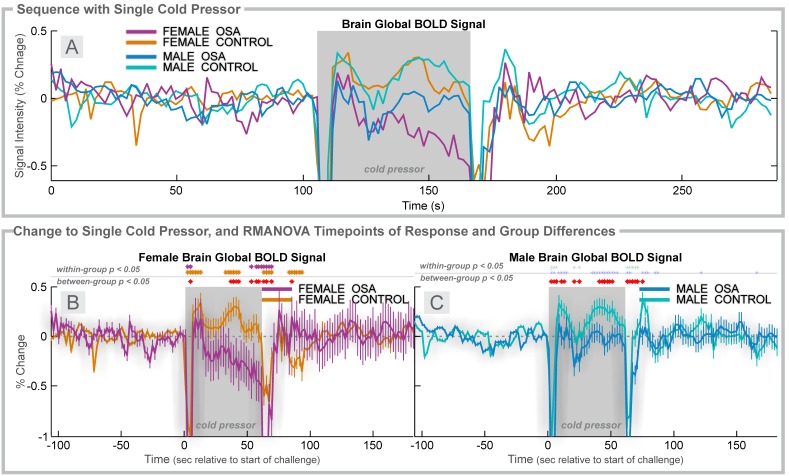
Cold pressor, 4 group.Time courses separated by sex of global BOLD signals during a cold pressor challenge (gray rectangles). A: Global BOLD signals in females (6 OSA, 20 control) and males (31 OSA, 37 control) during the complete sequence. For females (B) and males (C), changes in BOLD signals relative to baseline (group mean ± SE), with time-points of significant increase or decrease relative to baseline within-group, and time-points of between-group differences (RMANOVA, p<0.05).